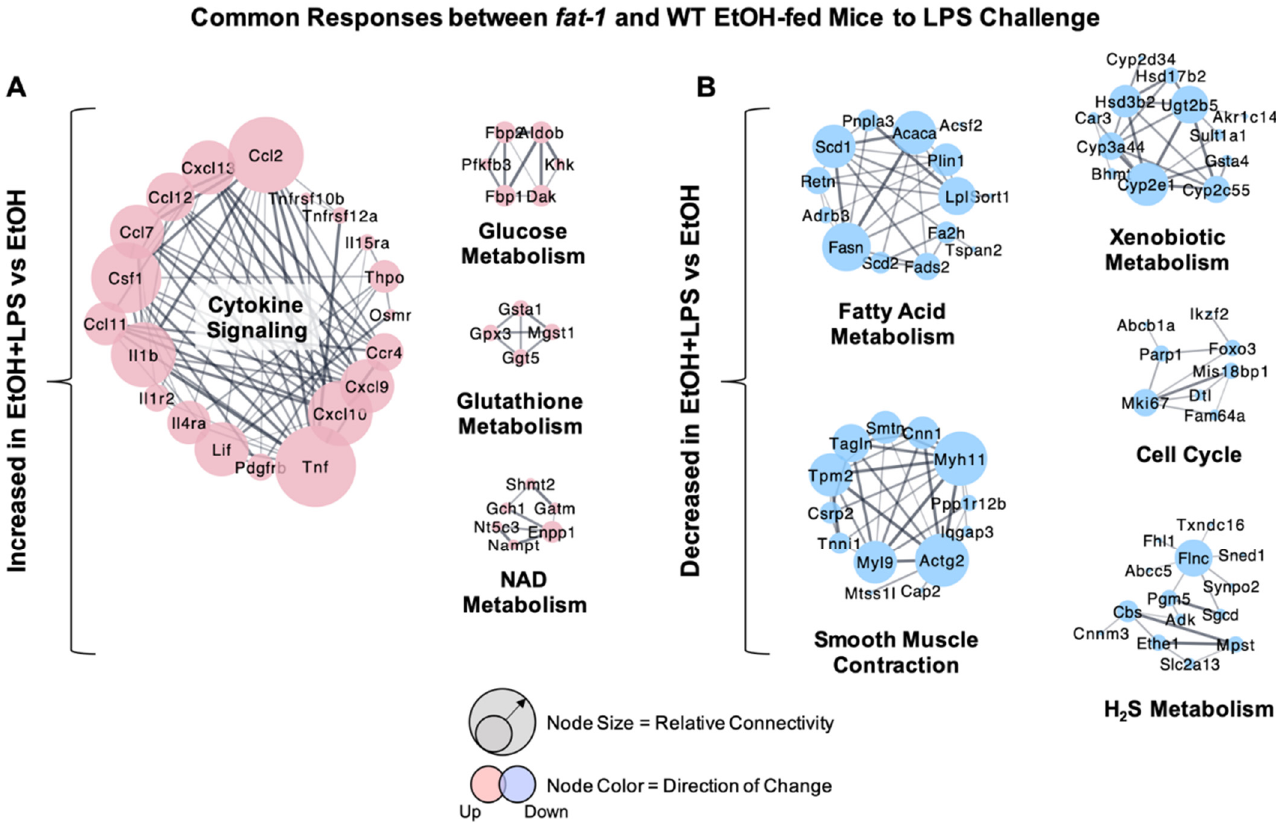
Figure 2. Similarity in transcriptional responses of ileum tissue to EtOH + LPS in WT and fat-1 mice. ( A ) Cluster analysis of ileum genes increased by EtOH + LPS vs. EtOH in both WT and fat-1 mice. Node size indicates relative connectivity. ( B ) Cluster analysis of ileum genes decreased by EtOH + LPS vs. EtOH in both WT and fat-1 mice.